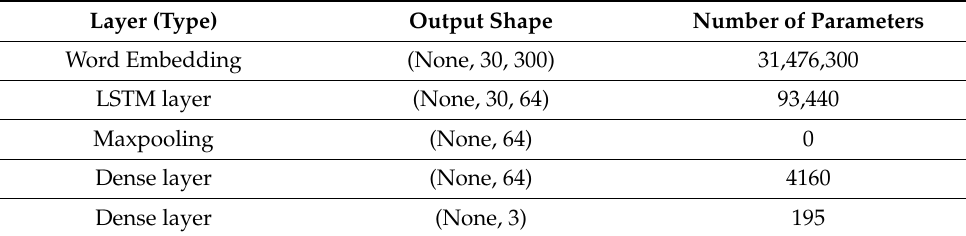
Table 4. Single-layer LSTM